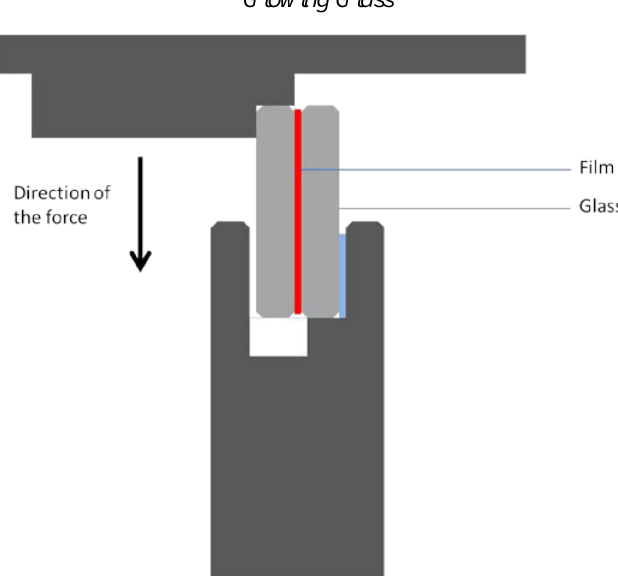
Fig. 19 Mechanism of the shear resistance test